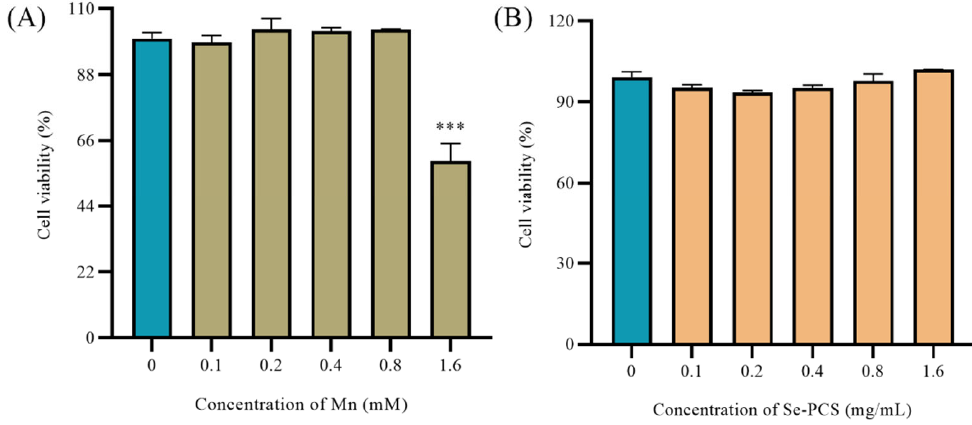
Figure 3. ( A ) The cell viability of Hep G2 under different concentrations of MnCl 2 ; ns means no difference and *** mean p < 0.001 compared with the group of 0; ( B ) the cell viability of Hep G2 under different concentrations of Se-PCS.